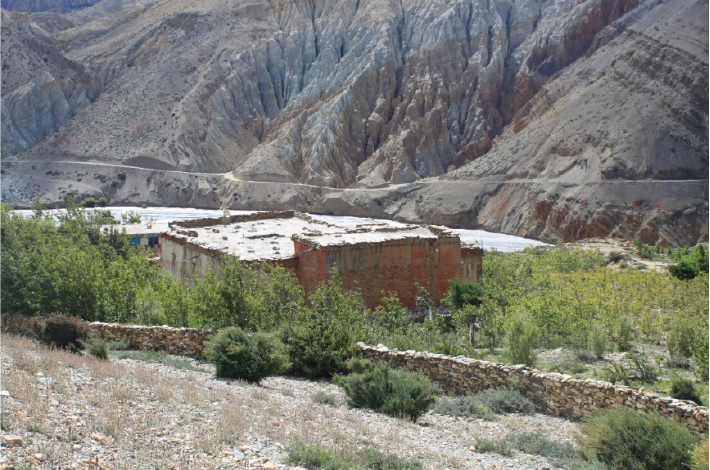
Figure 2. View of Gönpa Gang from the west. In the background the Kali Gandaki river and rock formations characteristic of the Upper Mustang region are visible.